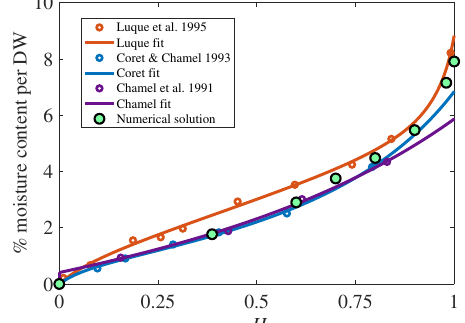
Fig. 1 Validation plot compared to experimental data 4,10,12 on isolated astomatous tomato fruit cuticles. The total experimental time in the data 4 and model is 6 h for each point, and experimental data are shown as open circles. Relative humidity, H , is shown as a fraction on the x -axis and the percentage moisture content on the y -axis is calculated with Supplementary Eq. (8). The green dots are the numerical solution results of the cuticle model, and the solid curves are simple fi ts described around Supplementary Table